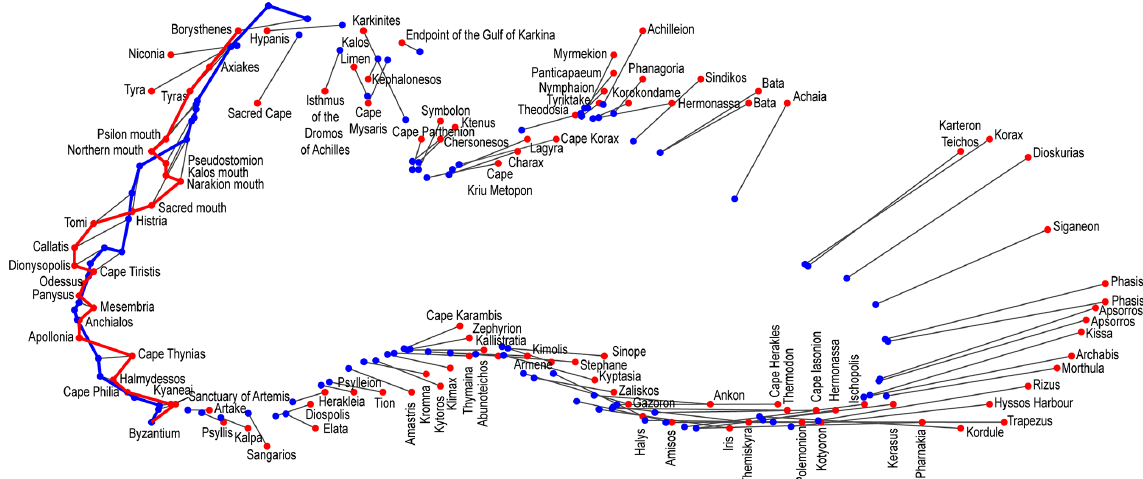
Figure 2. Displacement vectors connecting Ptolemy’s coordinate points on the coasts of the Pontus (red) and their modern counterparts (blue), constructed using the Darcy 2.2 program (Vuidel, 2009). Byzantium is set as a reference point, so that it is the only error free location, against which all the displacements of Ptolemy’s points relative to their counterparts on the modern map are measured. It is conspicuous that the outlines of Ptolemy’s Pontus appear stretched in the east–west directions due to the underestimated value of the circumference of the Earth.